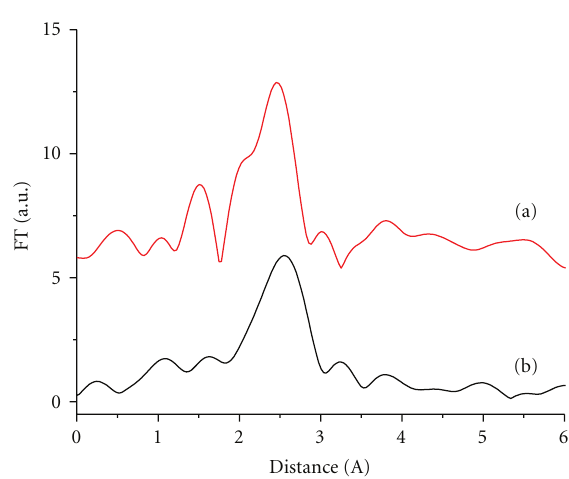
Figure 2: Fourier transforms of the Pt L III -edge EXAFS spectra for Img: Pt-ZnO-SiO 2 (a) and PAD: Pt-ZnO-SiO 2